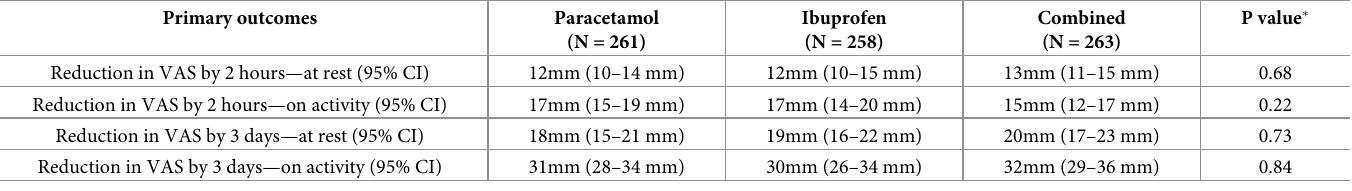
Table 2. Summary of primary outcomes VAS and the univariate